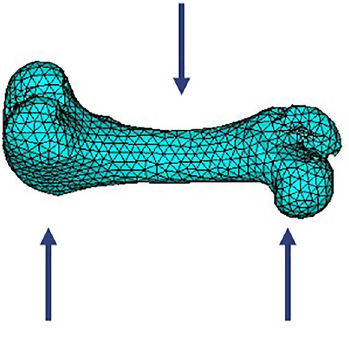
Fig. 5 Schematic of the location of boundary conditions applied to the specimen model